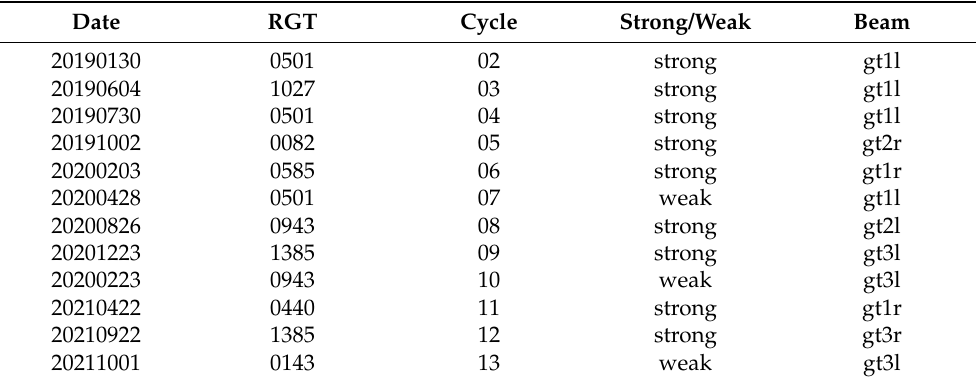
Table 2. ICESat-2 data with added systematic biases.